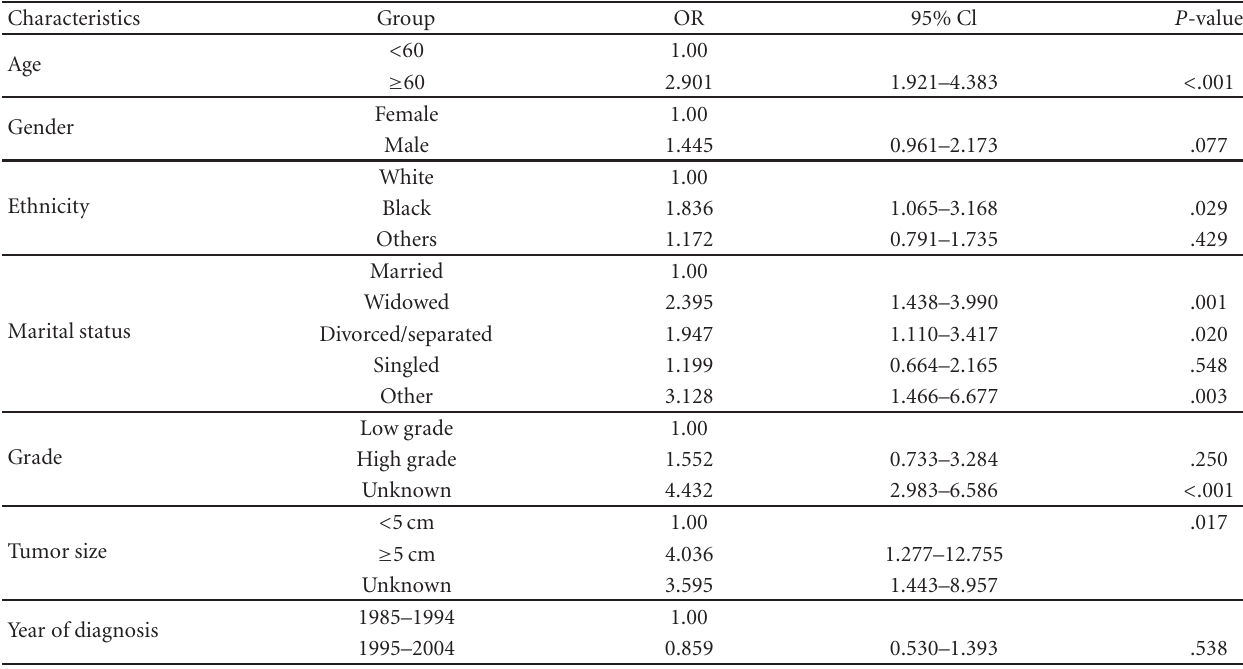
Table 4: Logistic regression analysis of factors associated with refusal of cancer-directed surgery in patients with localized HCC. Characteristics